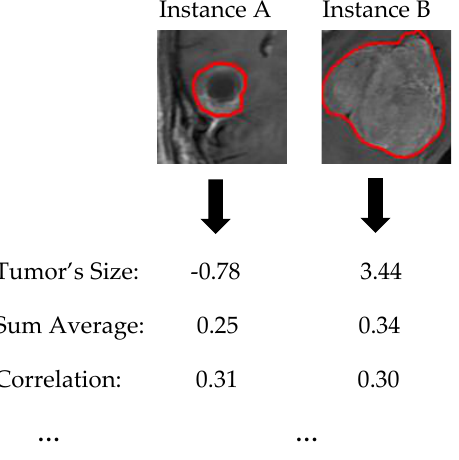
Figure 6. Two case study instances. Instance A is GLIOMA while Instance B is NON GLIOMA.